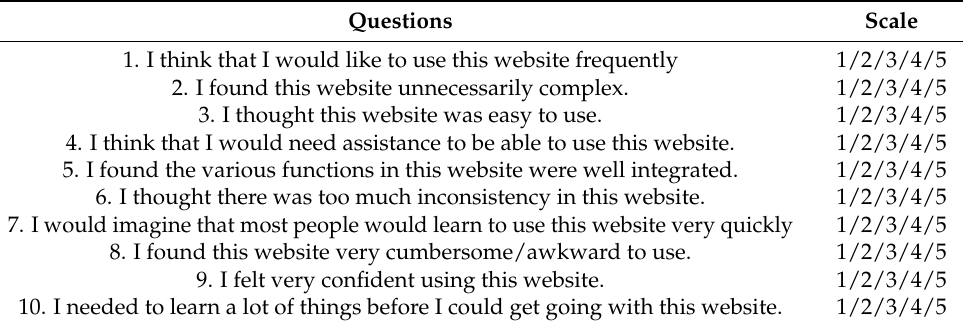
Table 2. System usability testing questionnaire with evaluation scale.